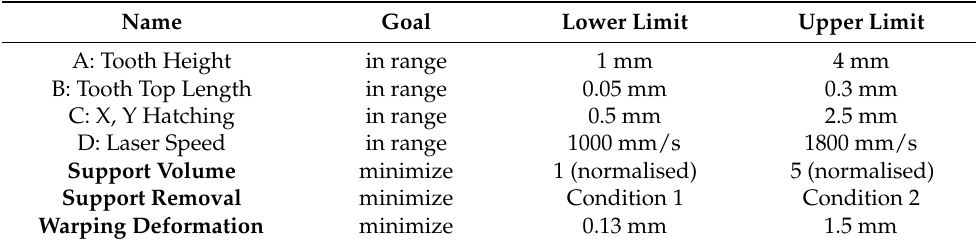
Table 9. Criteria constraints.